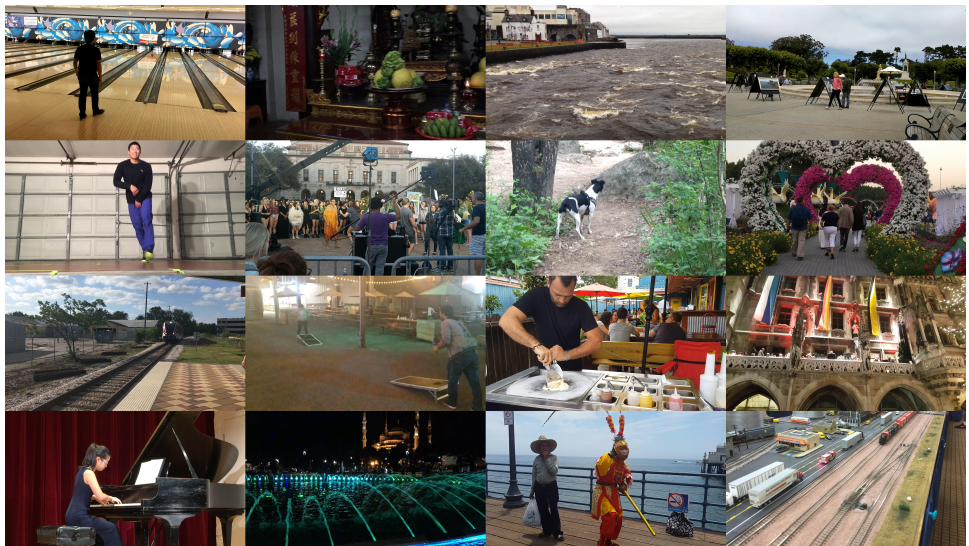
Figure 7. Illustration of several videos from LIVE VQC [26] VQA benchmark